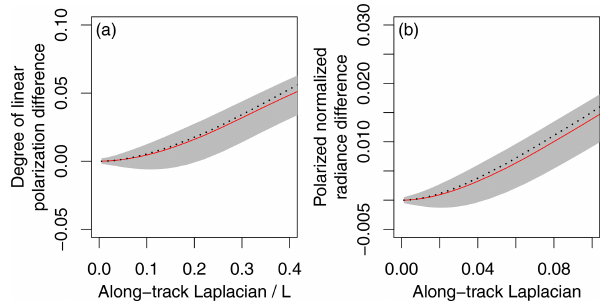
Figure 11. The same as Fig. 8 but with slope of − 3 .